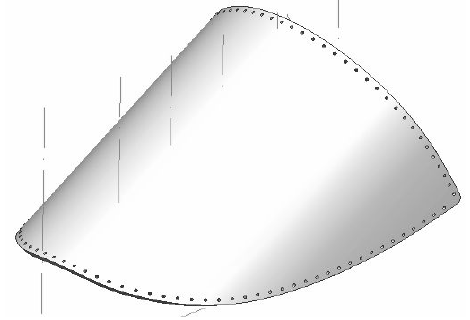
Fig. 2. The windshield in UG software.